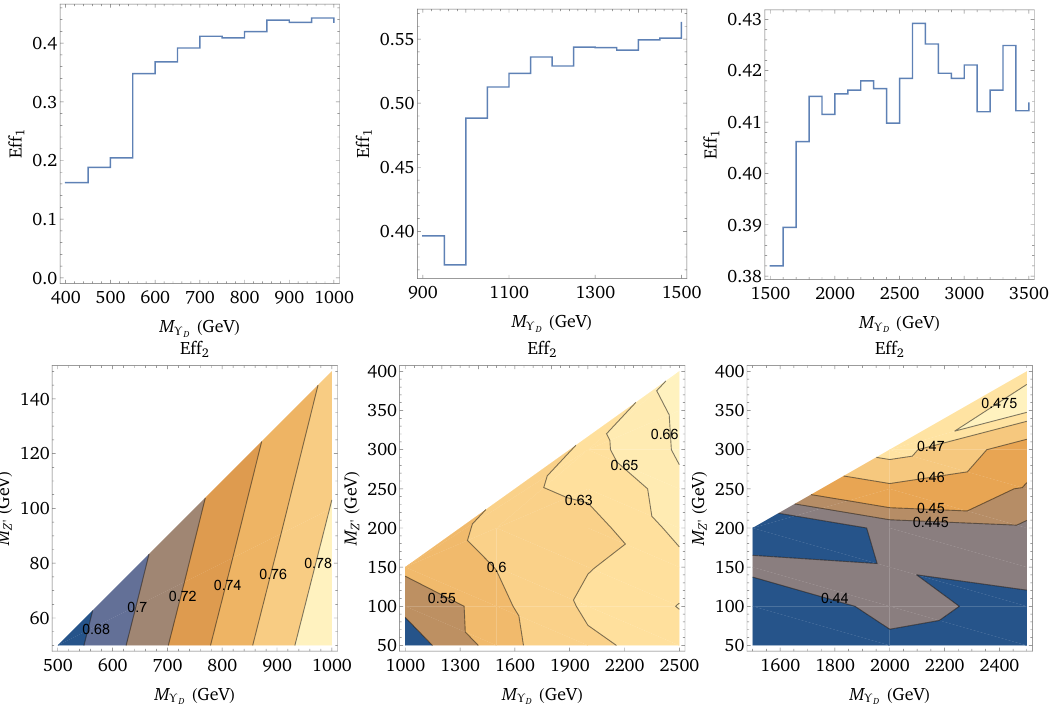
Figure 5 . The e(cid:14)ciency factors for the (cid:7) D ! q (cid:22) q (E(cid:11) 1 , (cid:12)rst tow) and (cid:7) D ! 2 Z 0 ! 2( q (cid:22) q ) (E(cid:11) 2 , second row) channels for passing the event selection cuts in three mass windows of dijet resonance searches for new vector